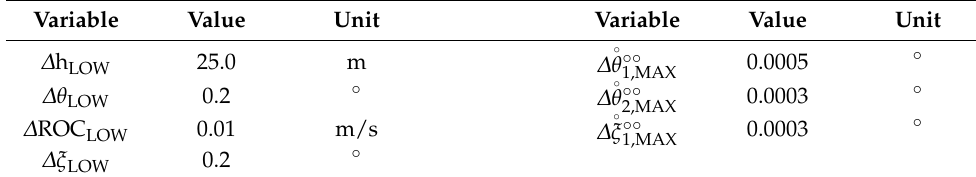
Table 2. Pitch and bank adjustment